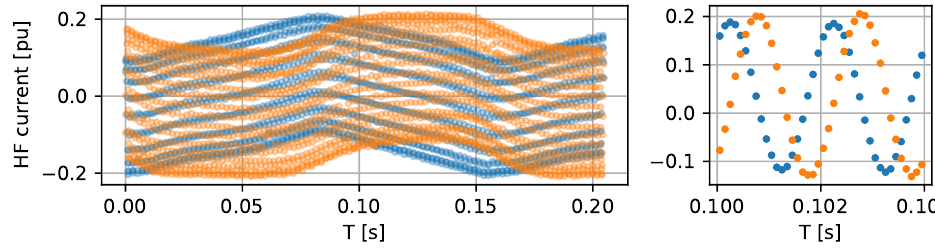
Figure 3. General view of raw data used in the process. ( Left ): full set #1 of currents in the α -axis and β -axis, which are used to build the hodograph after preprocessing. ( Right ): an enlarged fragment of this set. HF current: f = 500 Hz. Data collected during the slow rotation of the motor shaft. Currents related to nominal value